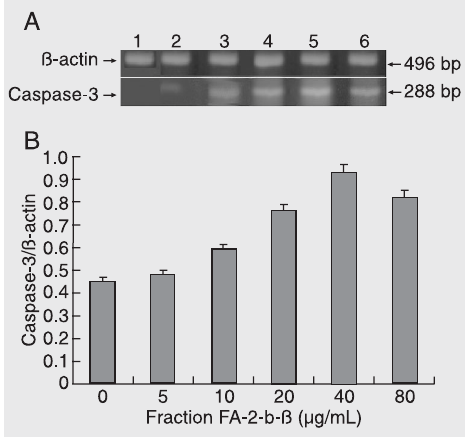
Figure 5. RT-PCR assays of caspase-3 mRNA of HL-60 cells (1 x 10 5 cells/mL) treated with fraction FA-2-b-ß. A , Lanes 1-6 : HL-60 cells were treated with 0, 5, 10, 20, 40, and 80 µg/mL frac- tion FA-2-b-ß for 96 h, respec- tively. B , The ratio of mRNA con- tent between caspase-3 and ß-